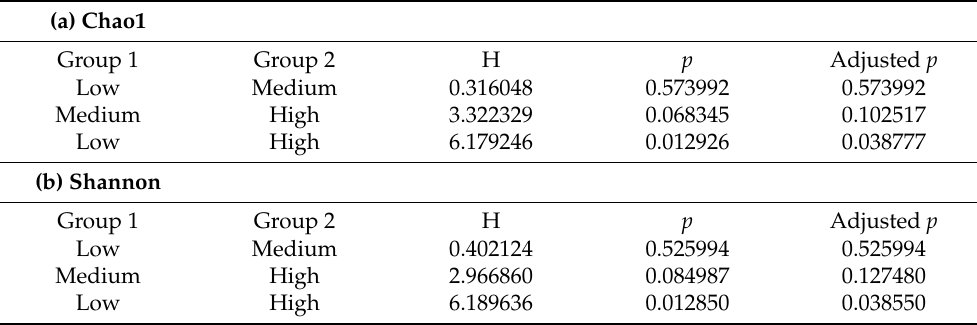
Table 2. Pairwise comparisons (Kruskal–Wallis test) of alpha diversity between samples using ( a ) Chao1 and ( b ) Shannon indices, where adjusted p was computed following the Benjamini–Hochberg procedure.